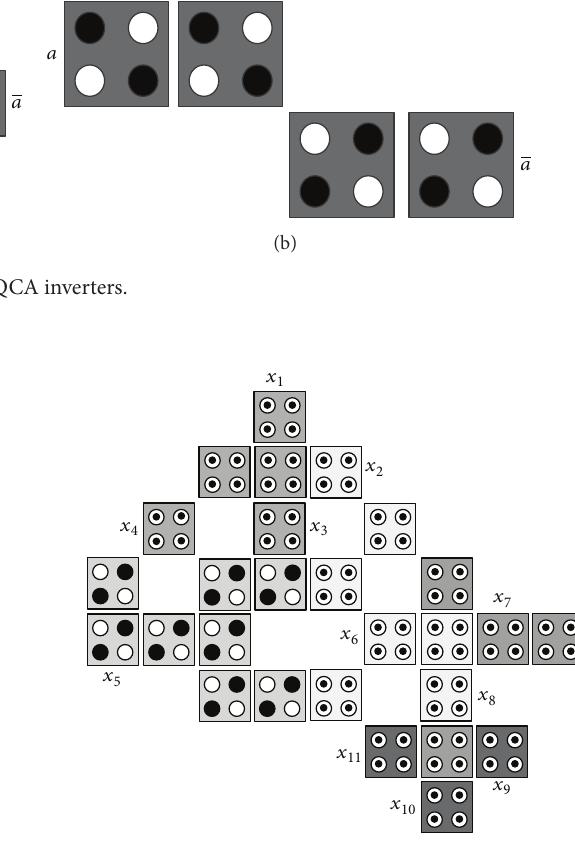
Figure 7: The proposed basic building block where the customiza- tion cells are 𝑥 1 , 𝑥 2 ,...,𝑥 11